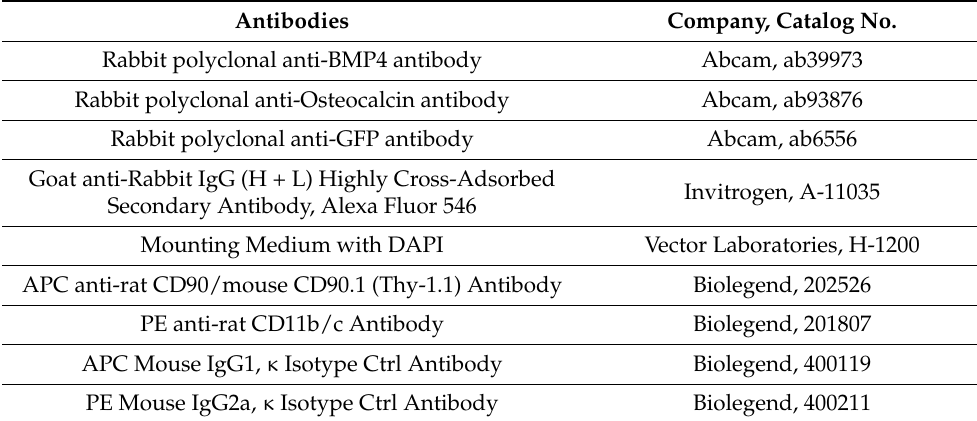
Table 2. Antibodies for immunostaining and flow